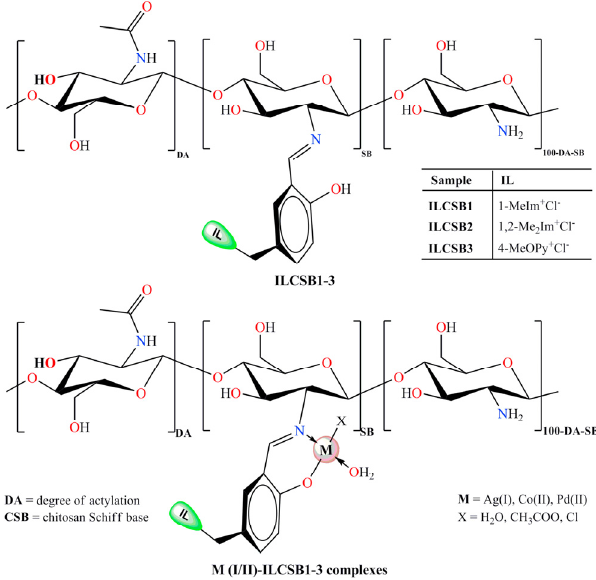
Scheme 4. Schematic representation of IL-anchored chitosan Schiff bases and their metal complexes. Reproduced with permission from